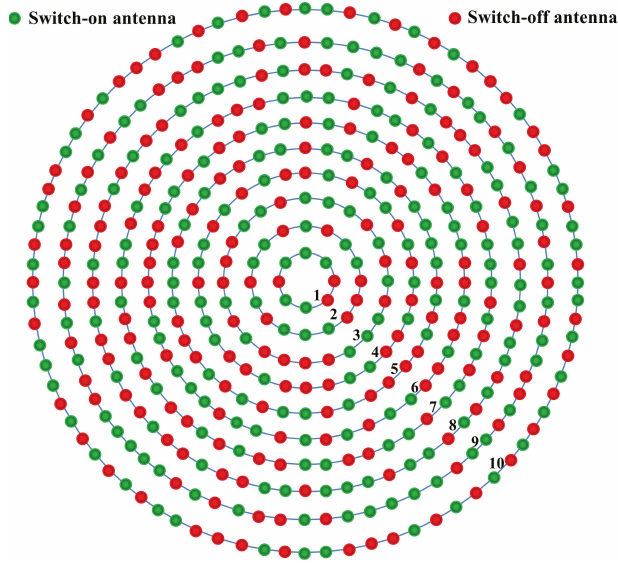
Figure 5. State of the